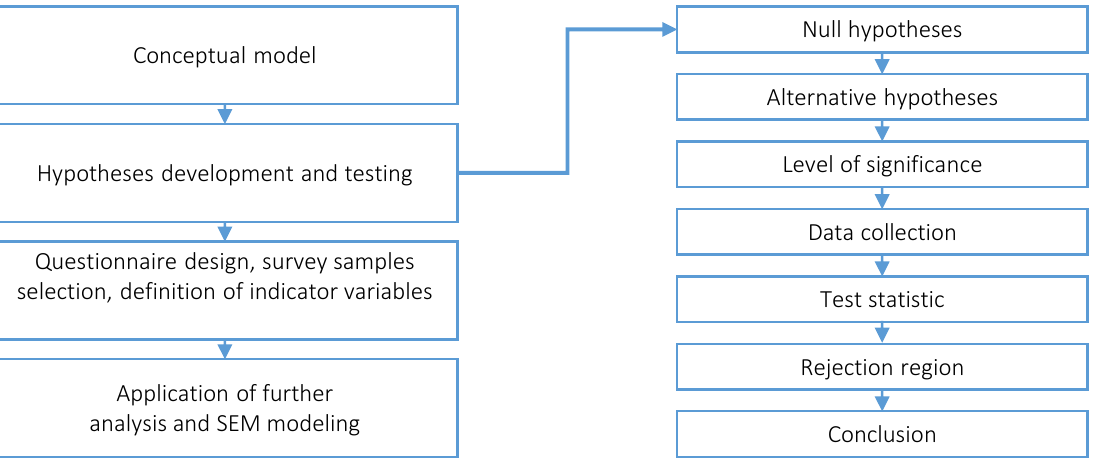
Figure 3. Research model and hypotheses testing steps